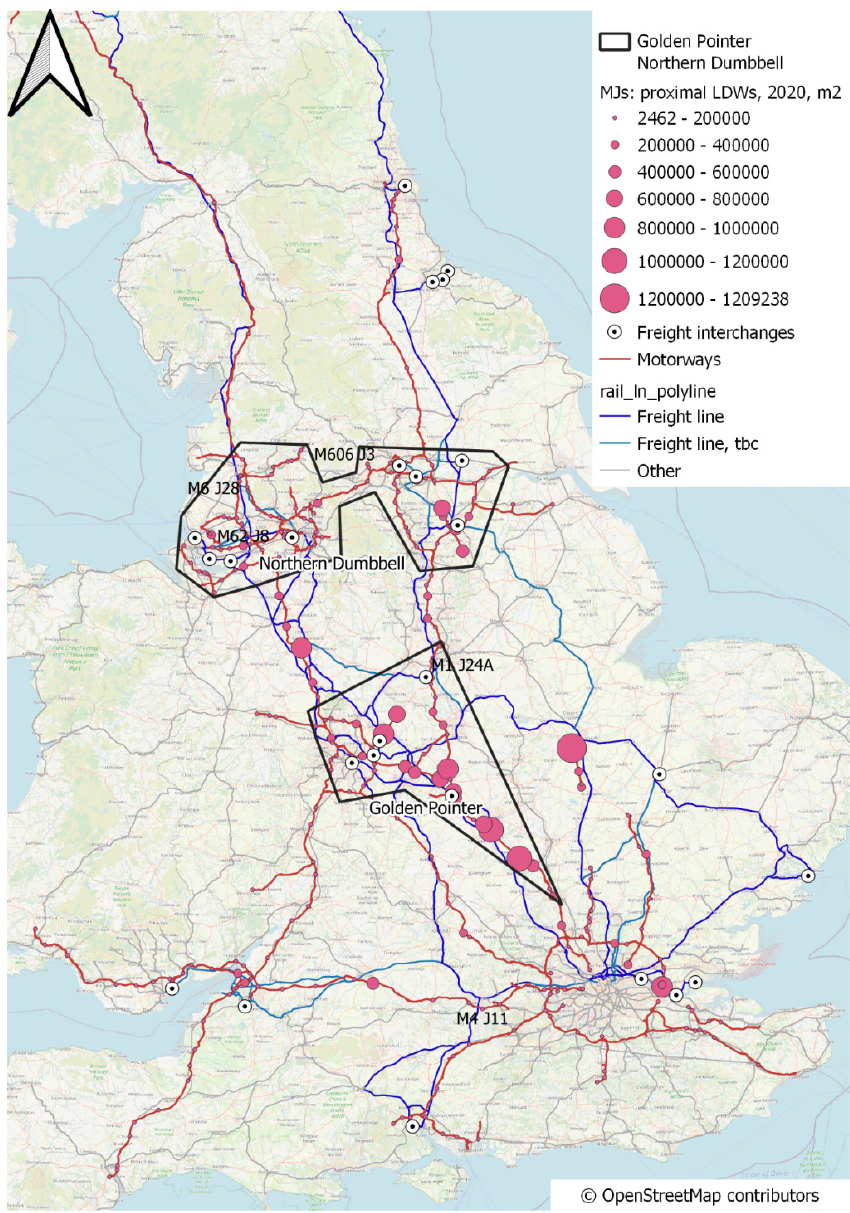
Figure 3. LDW floorspace (m 2 ) proximal to MJs,